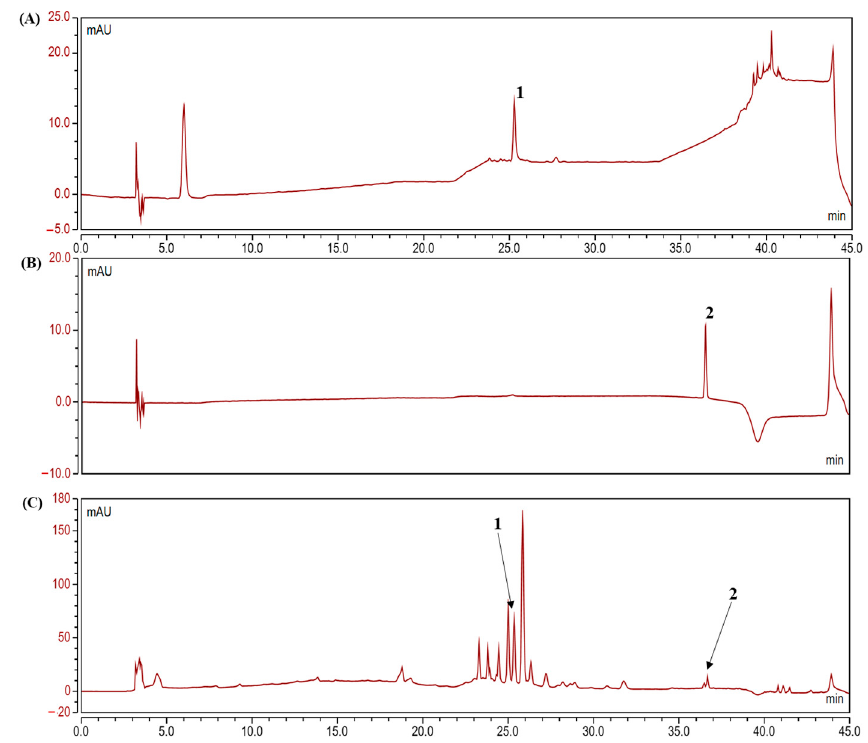
Figure 1. The HPLC (high ‐ performance liquid chromatography) results of ellagic acid (peak 1) and quercetin standards (peak 2) ( A , B ) and the contents of ellagic acid and quercetin in the camu ‐ camu fruit extract ( C ).